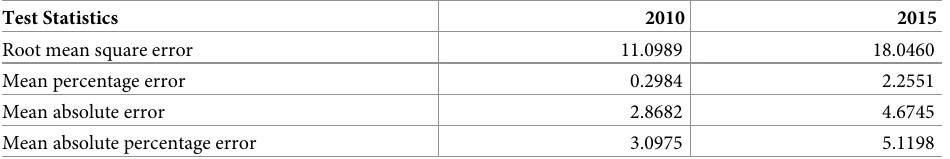
Table 1. Validation statistics. Fit statistics for out-of-sample population projections (number of people in thousands) of US Counties in 2010 and 2015. Projections generated by na ï ve extrapolation from equations fit with data through